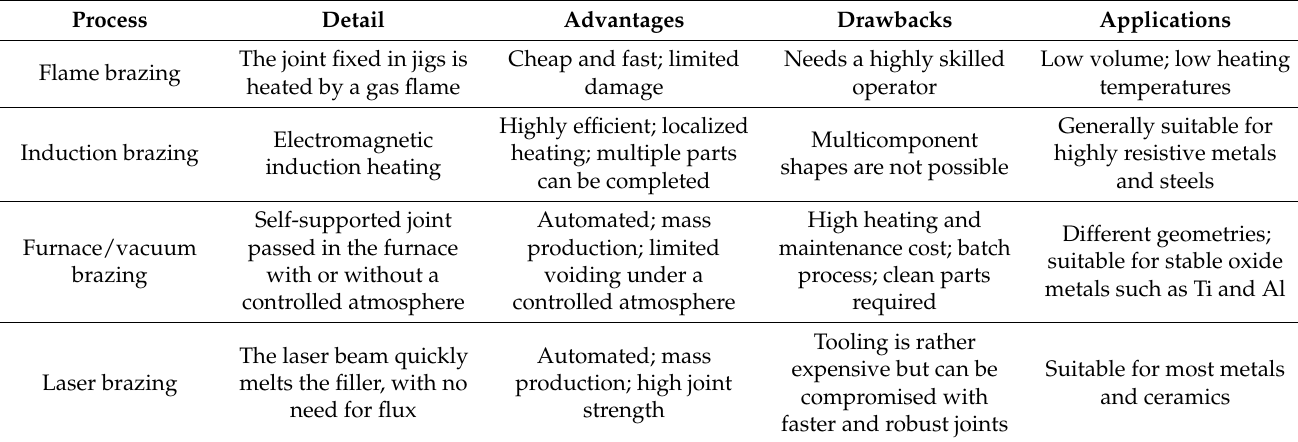
Table 1. Overview of various brazing methods, their advantages, drawbacks, and applications [1,2]. Process